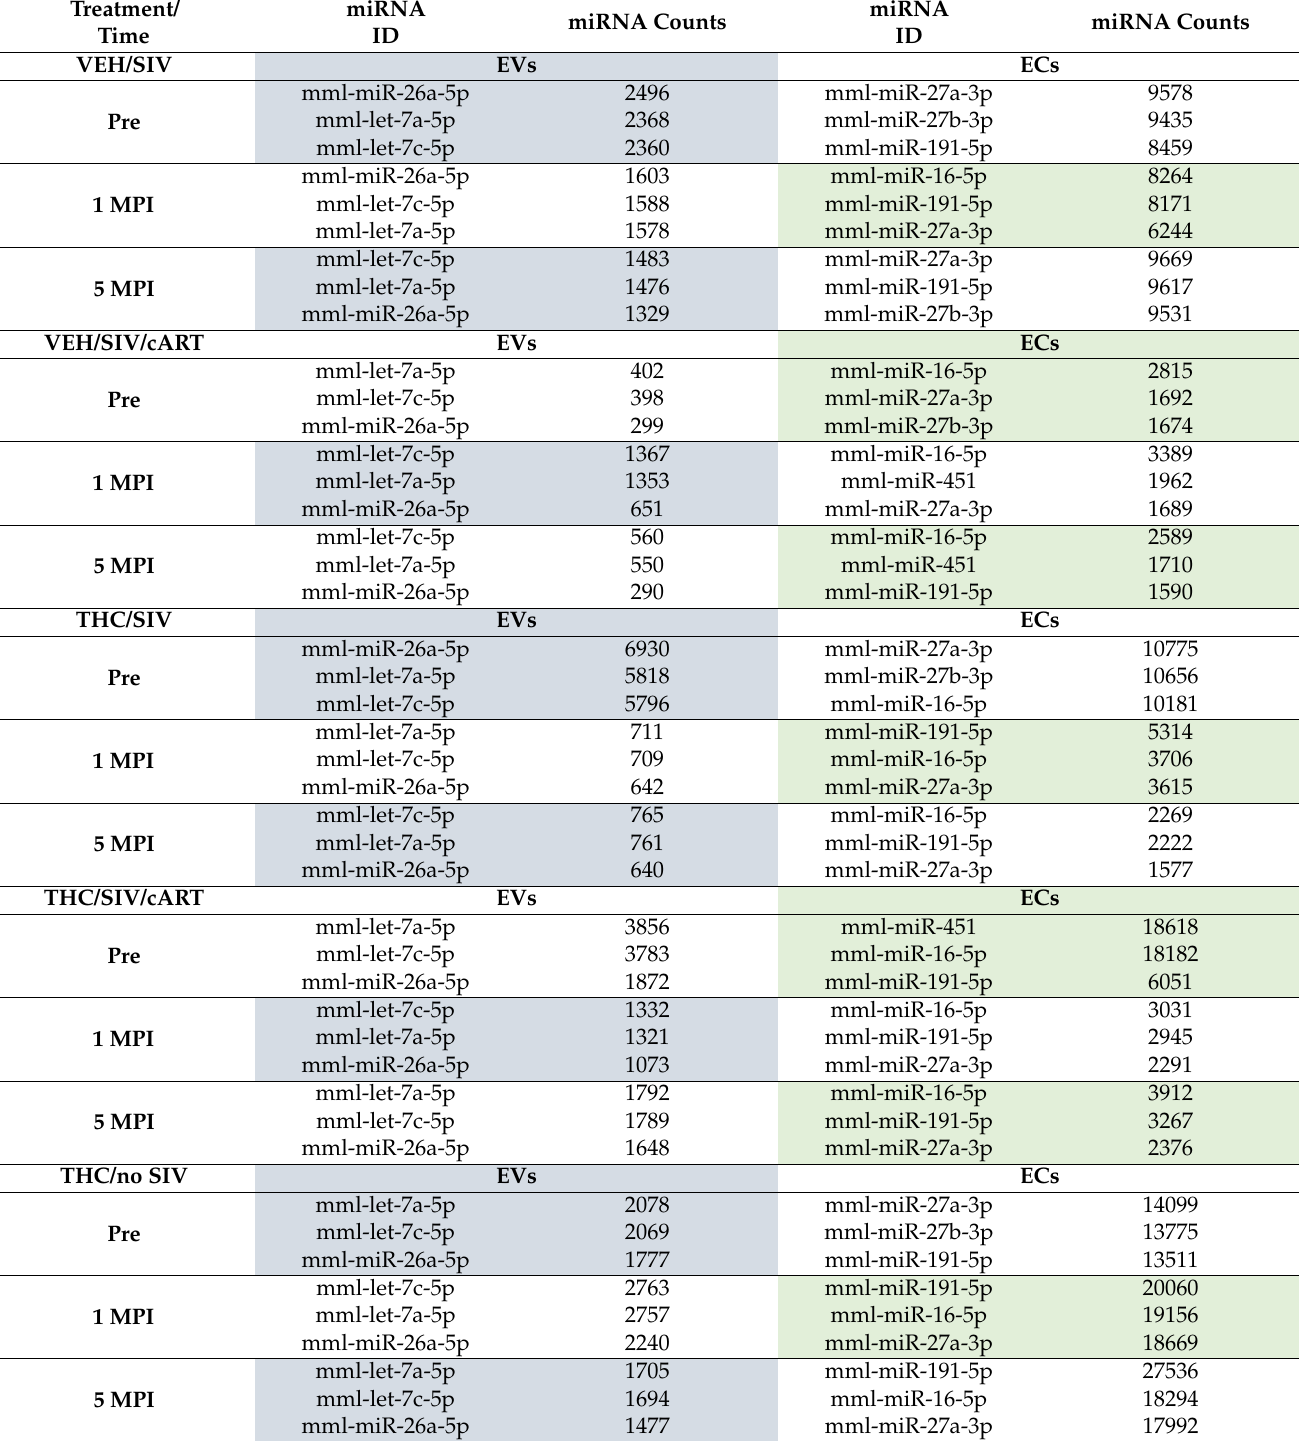
Table 3. Most highly enriched miRNA by counts in EVs and ECs in various groups at different times.